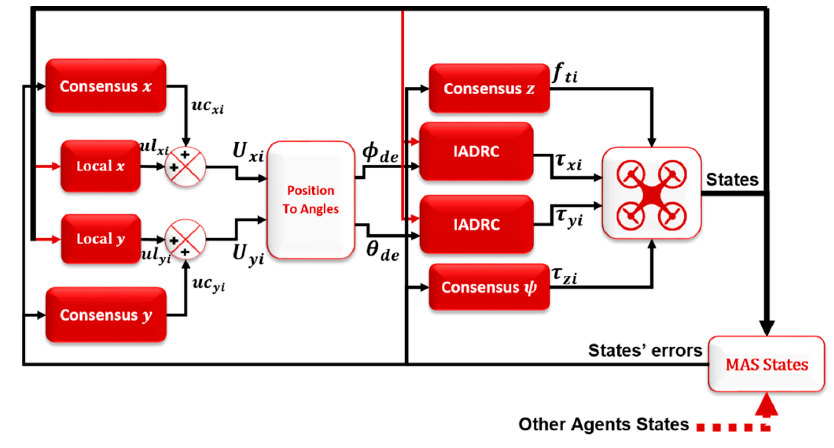
Figure 6. The overall ith quadrotor system with the consensus controller.